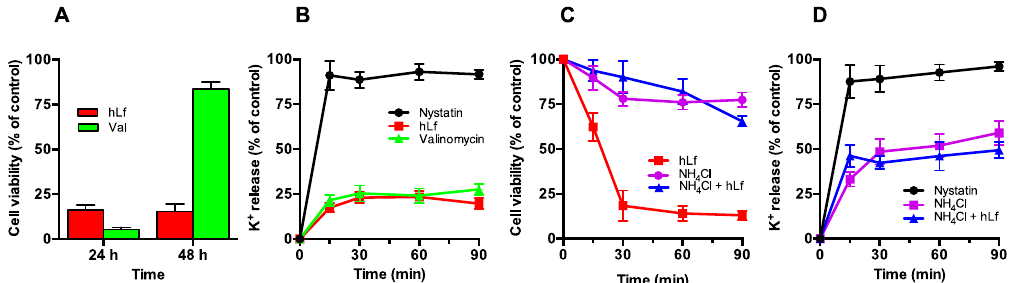
Figure 3. E ff ect of di ff erent K + -depletion inducers on cell viability. ( A ) Antifungal activity of lactoferrin and valinomycin. The cells (10 5 cells / mL) were incubated in Tris bu ff er for 90 min at 37 ◦ C with 5 µ M lactoferrin (hLf, red column) or 50 µ g / mL valinomycin (Val; green column) and cell viability was calculated at 24 h and 48 h. ( B ) Time-course of K + release induced by lactoferrin and valinomycin. The K + released was measured at di ff erent times after the addition of 20 µ M lactoferrin (red line), 50 µ g / mL valinomycin (green line), or 100 µ g / mL nystatin (black line, positive control) to cell suspensions (10 7 cells / mL). ( C ) E ff ect of NH 4 Cl on viability of lactoferrin-treated cells. The time-kill curve of cells (10 5 cells / mL), pre-incubated in the presence of 10 mM NH 4 Cl and treated with (blue line) or without 5 µ M hLf (purple line) to determine cell viability. Lactoferrin-treated cells in the absence of NH 4 Cl (red line) were used as control. ( D ) Time-course of K + -release in the presence of NH 4 Cl. Cell suspensions were treated with (blue line) or without 20 µ M hLf (purple line) in the presence of 10 mM NH 4 Cl. The K + release was determined at different times of the incubation period performed at 37 °C. Nystatin (100 μ g/mL) was used as positive control in the measurements of released K + . Each value shown is the mean ± SD from duplicates of at least three independent experiments.